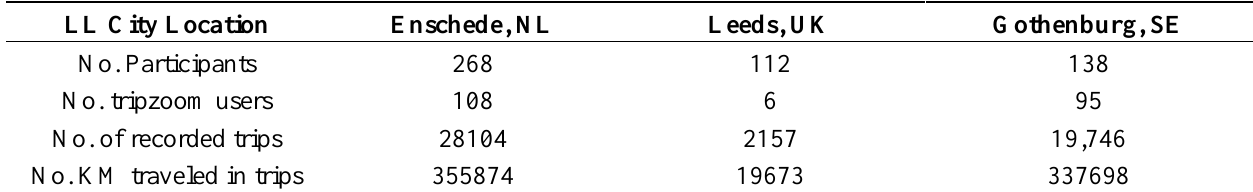
Table 4. Characteristics of users recruited for the tripzoom evaluation.